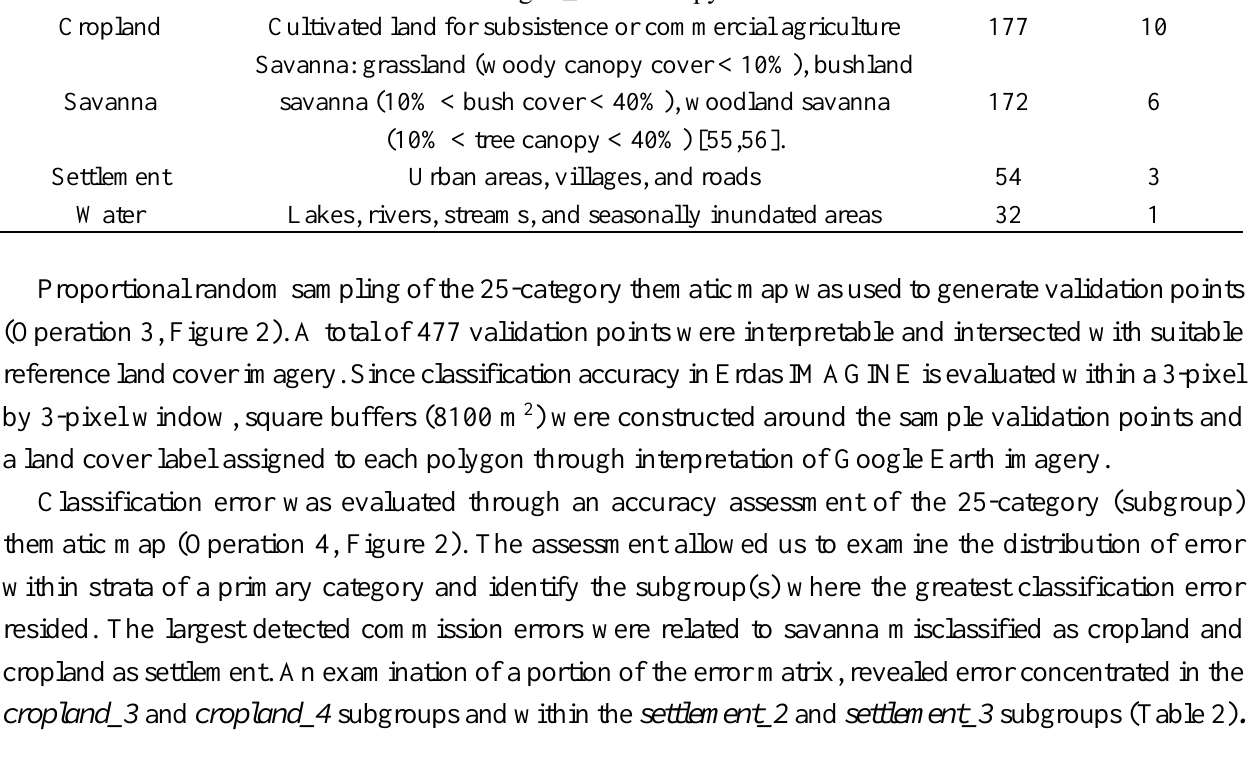
Table 2. Partial classification error matrix containing cropland and settlement subgroups. Rows represent the classified subgroup map categories and columns represent reference or validation data. High commission errors are indicated by